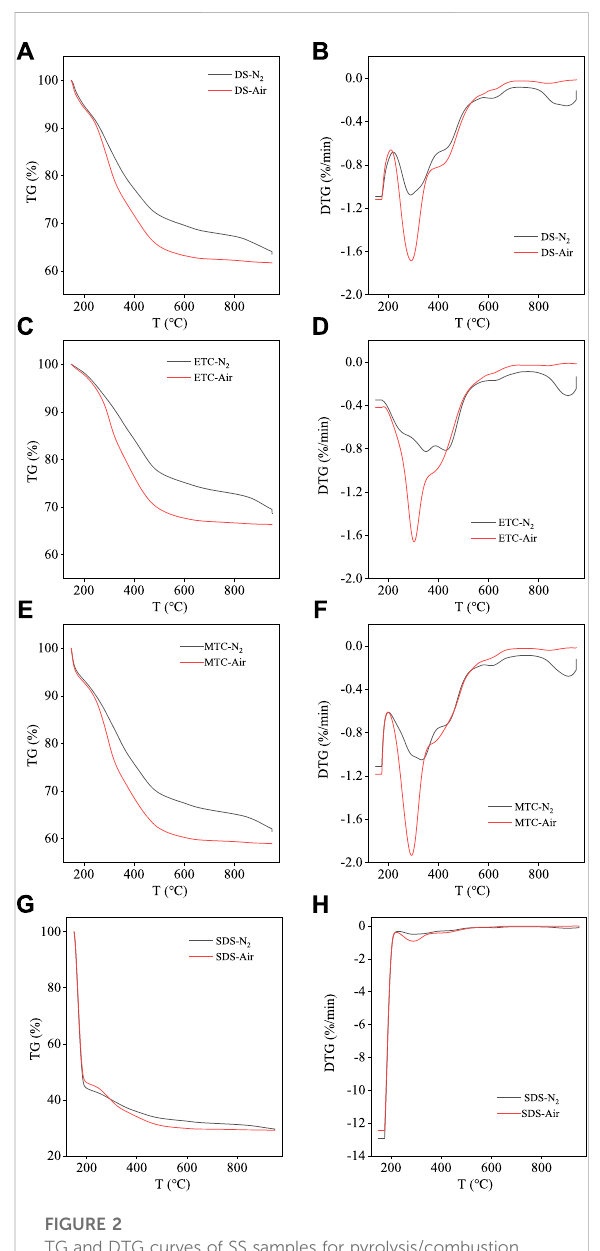
FIGURE 2 TG and DTG curves of SS samples for pyrolysis/combustion of DS (A,B) , ETC (C,D) , MTC (E,F) and SDS (G,H) at 10 °